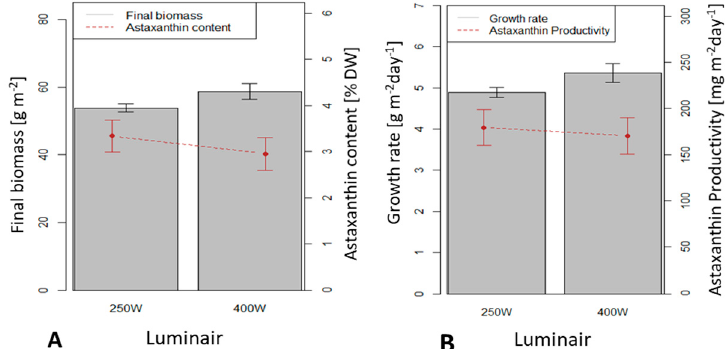
Figure 9. Dry biomass productivity and astaxanthin content and productivity in H. pluvialis with two different light sources. ( A ) Final biomass and astaxanthin content; ( B ) Biomass growth rate and astaxanthin productivity.